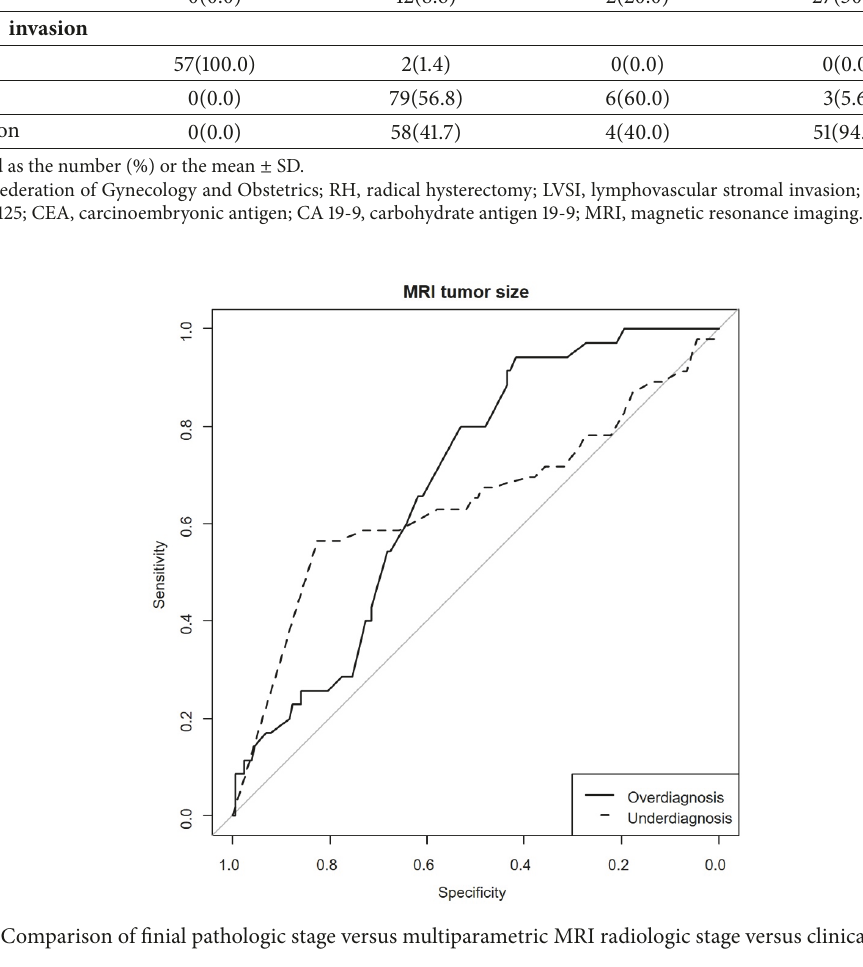
primary tumor size, the depth of cervical stromal invasion, and extension to the uterine corpus in patients with cervical cancer patients [7, 15–20, 24, 25].